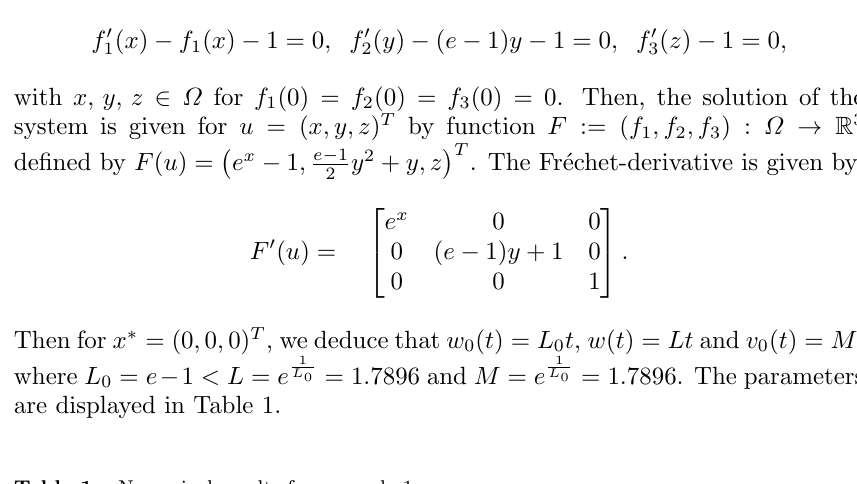
Table 1. Numerical results for example 1 M 5 , 1 M 6 , 1 M 7 , 1 M 8 , 1 r 1 = 0 .